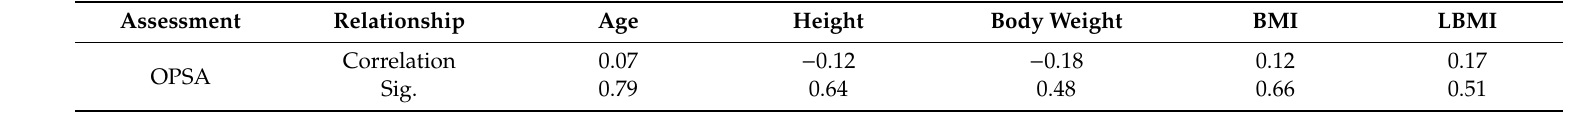
Table 2. Pearson’s correlations between demographic and anthropometric measures and the OSPA.